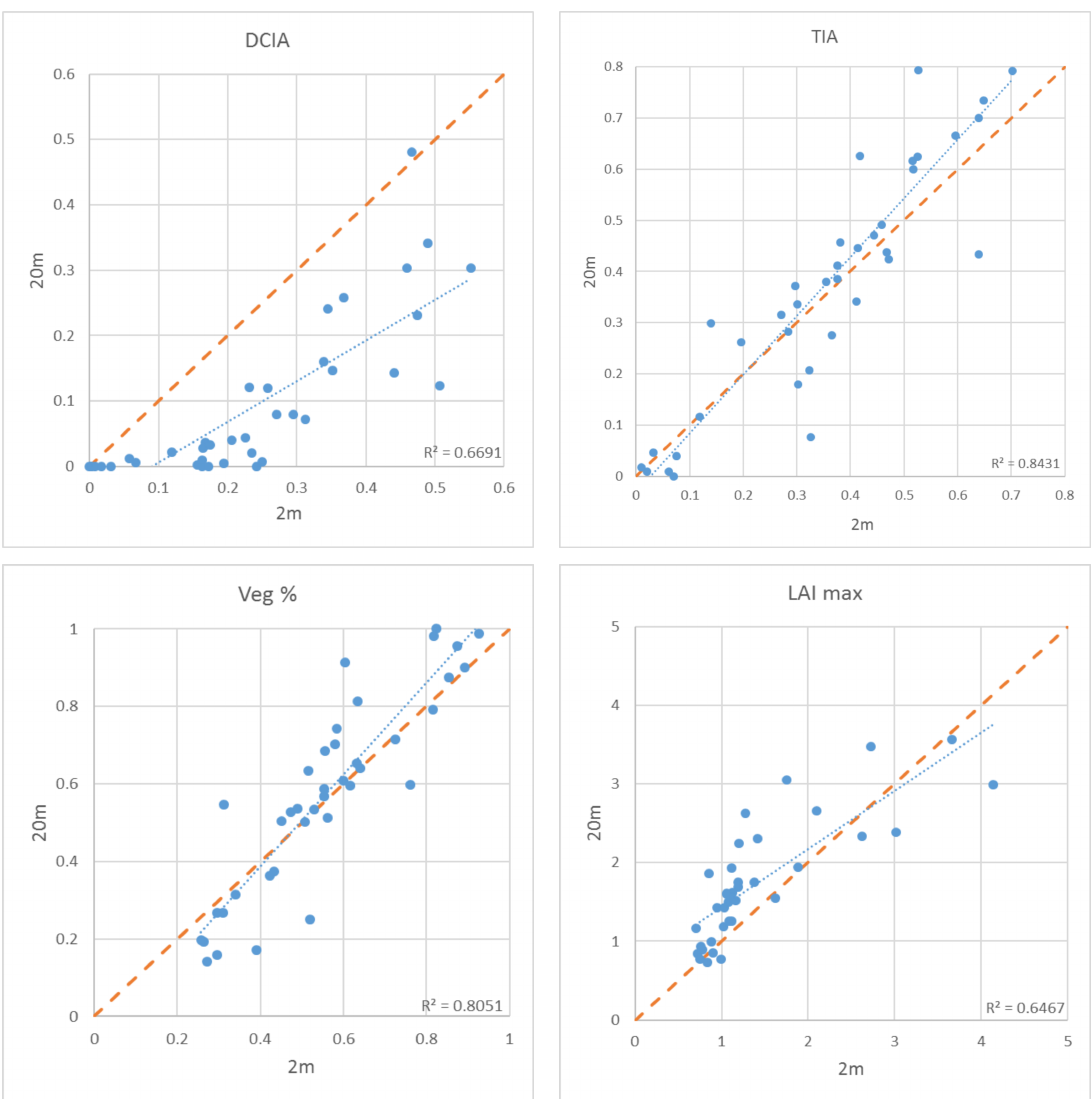
Figure 2. Spatial metrics for the 39 sub-catchments of the Watermaelbeek. Differences at a 2 m versus 20 m resolution for directly connected impervious area (DCIA), total impervious area (TIA), Vegetation cover (Veg%) and maximum leaf area index (LAI max).